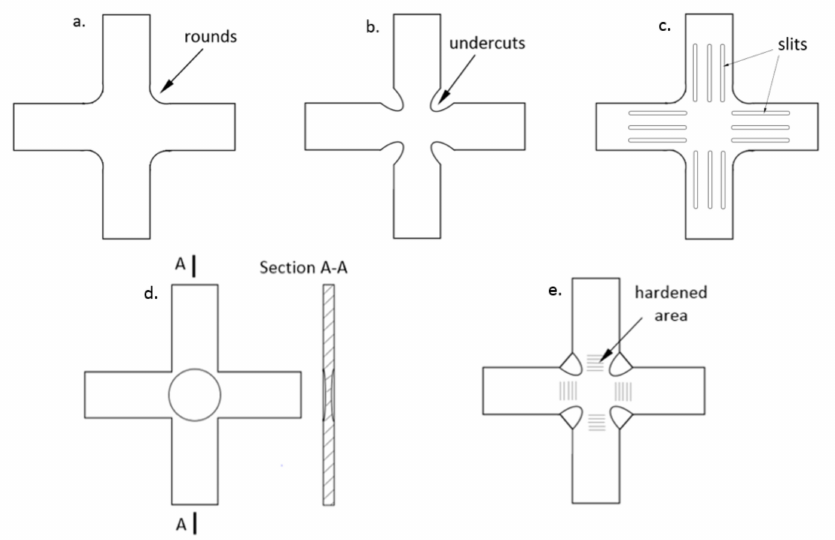
Figure 2. Different solutions for sample shape modification for higher plastic strain in the gauge region: ( a – c ) cut type, ( d ) reduced section type, ( e ) with hardened